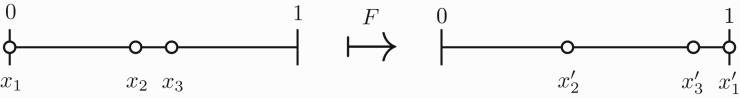
An illustration of the map F with k=3; F(x
2, x
3)=(x′2, x′3).